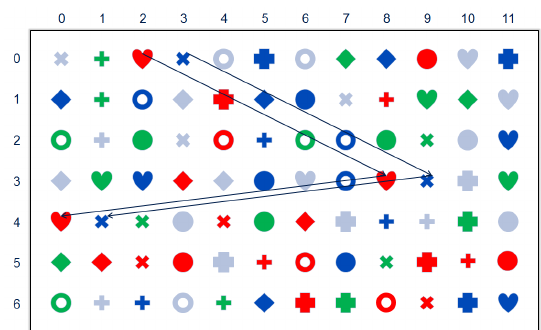
Figure 7 . Search plus